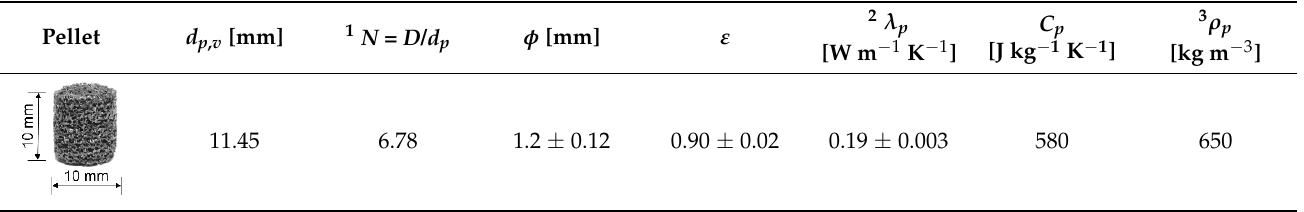
Table 1. Basic properties of foam pellet.